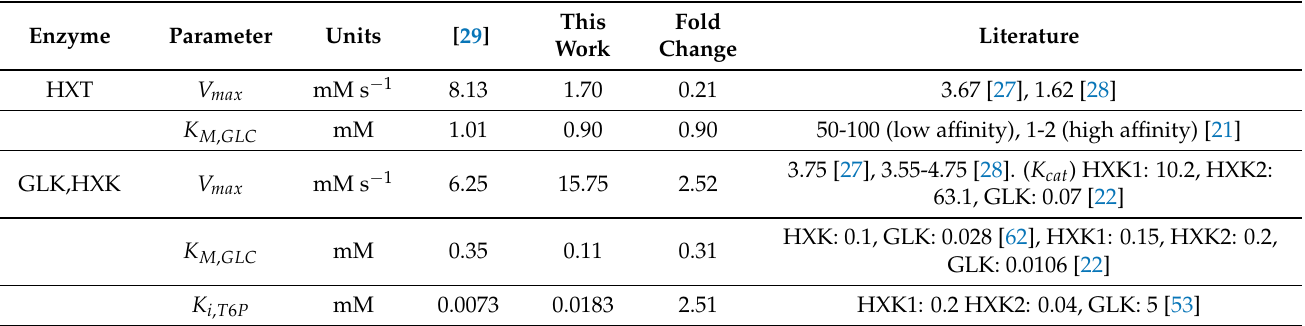
Table 1. Several parameters explain the adaptations in HXT and HXK isoenzymes. Changes in parameters in HXT and HXK kinetics allow the Y3M1 model to fit the data. For the other parameters in these reactions, changes were below